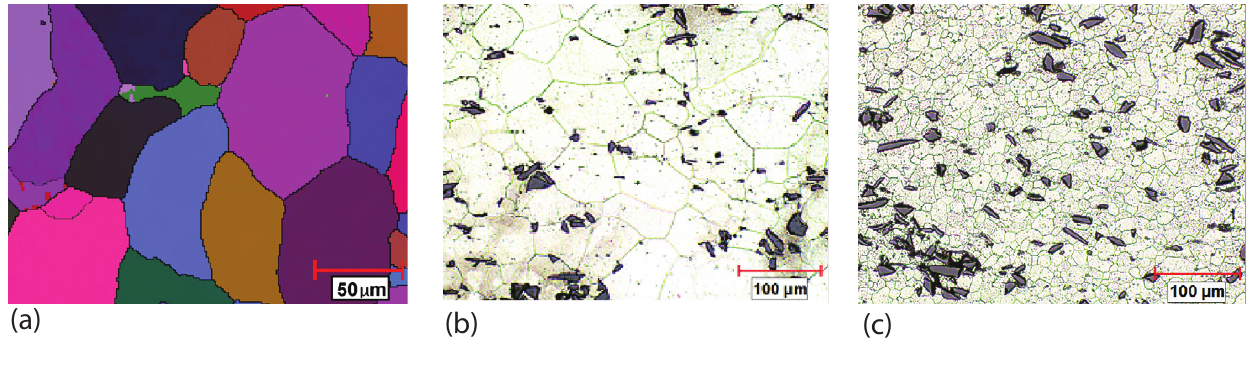
Figure 7 . AA6063 and B C particle reinforced composite (after Chen et al. [62]): (a) EBSD 4 orientation map showing the grains of AA6063; (b) B FSP; (c) B C particle reinforced composite after 4